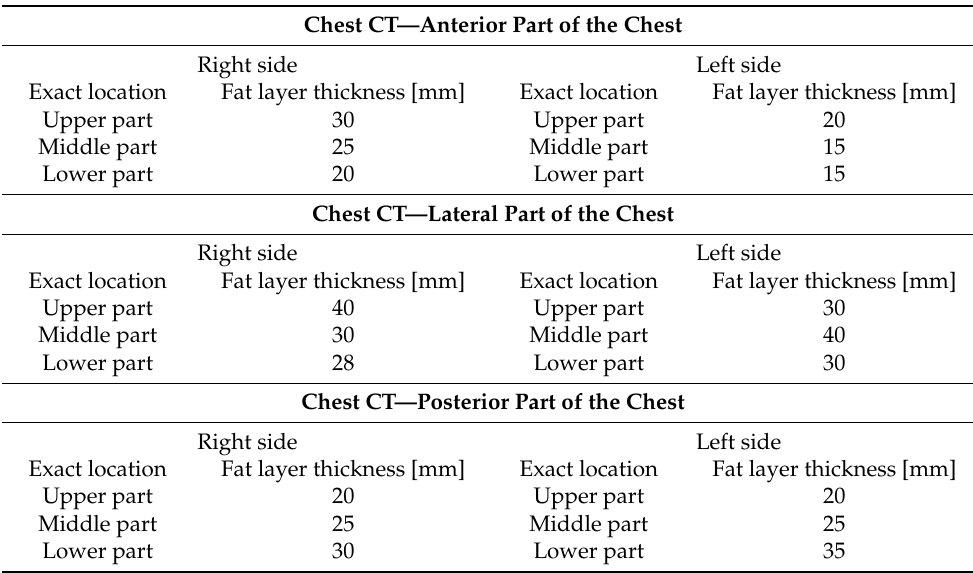
Figure 1. Computed tomography of the neck. ( A ) Axial reconstruction. ( B ) MPR reconstruction, frontal view. ( C ) MPR reconstruction, sagittal view. ( D ) VRT reconstruction. Table 2. Computed tomography of the chest. The exact location of adipose tissue overgrowth and measurement of its thickness.